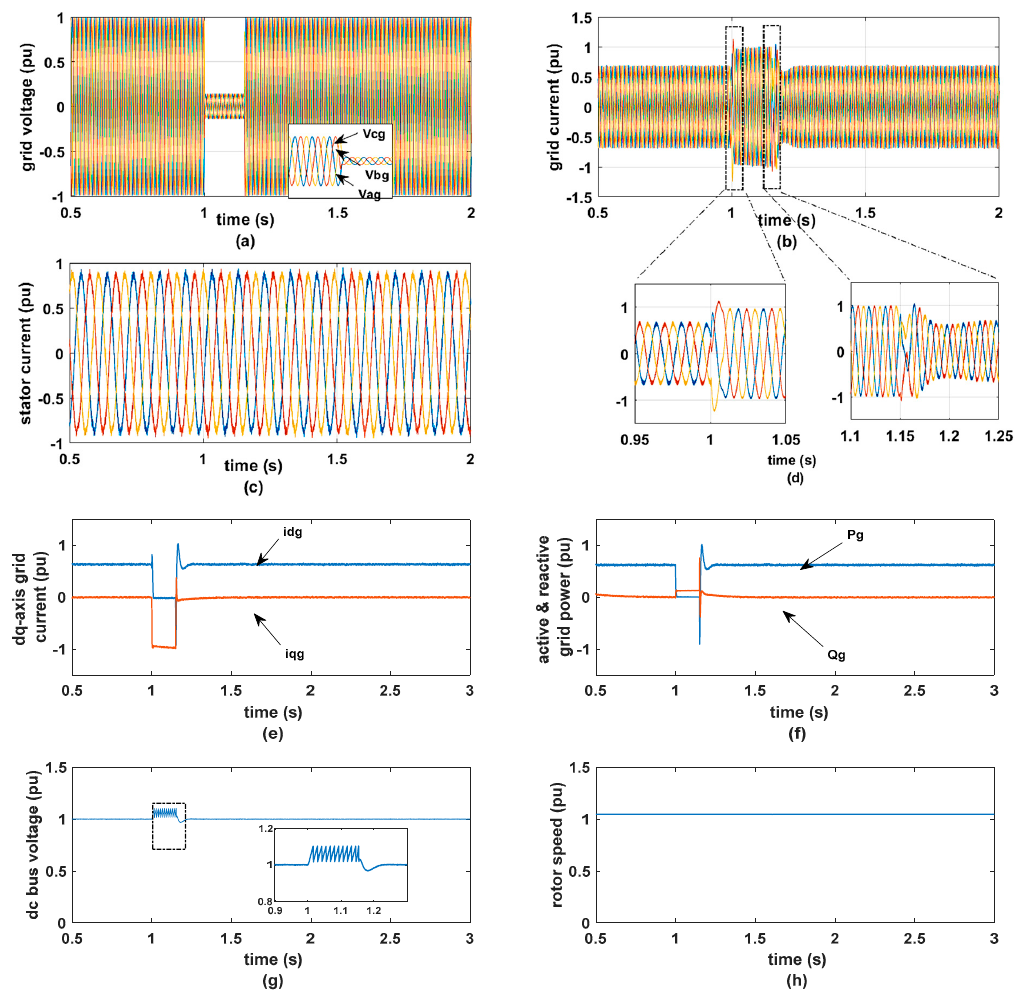
Figure 13. Simulation results of proposed MMPC under three phase grid voltage dip and grid-side converter LVRT capa- bility.